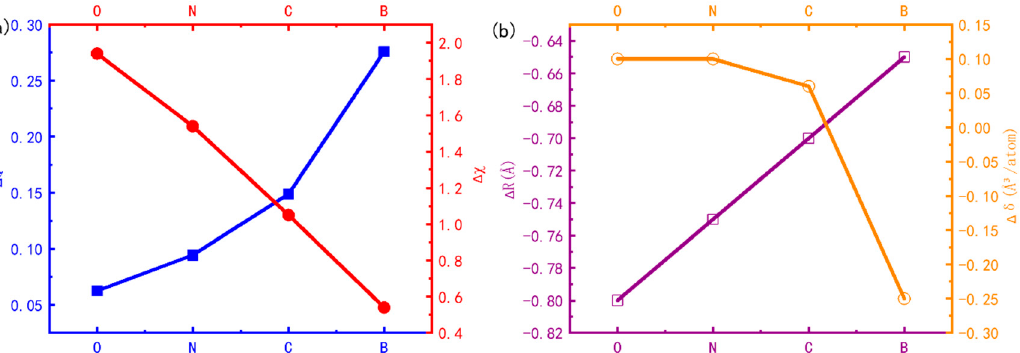
Figure 6. ( a ) The relative Pauling’s electronegativity ( ∆ χ ), the relative Bader charge ( ∆ Q); ( b ) The Figure 6. (a) The relative Pauling’s electronegativity ( Δ χ ), the relative Bader charge ( Δ Q); (b) The